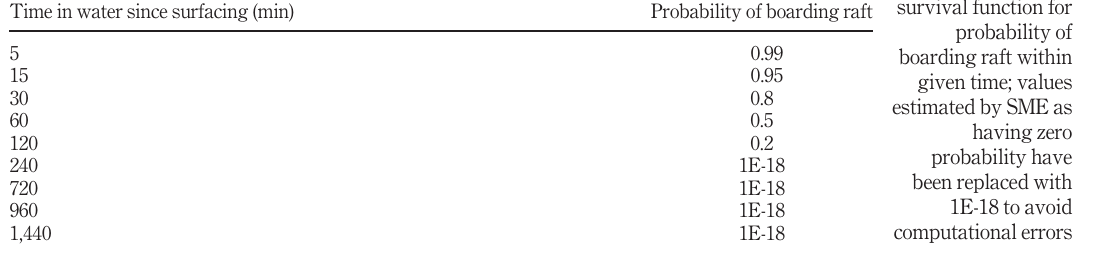
Table 1. SME estimated survival function for probability of boarding raft within given time; values